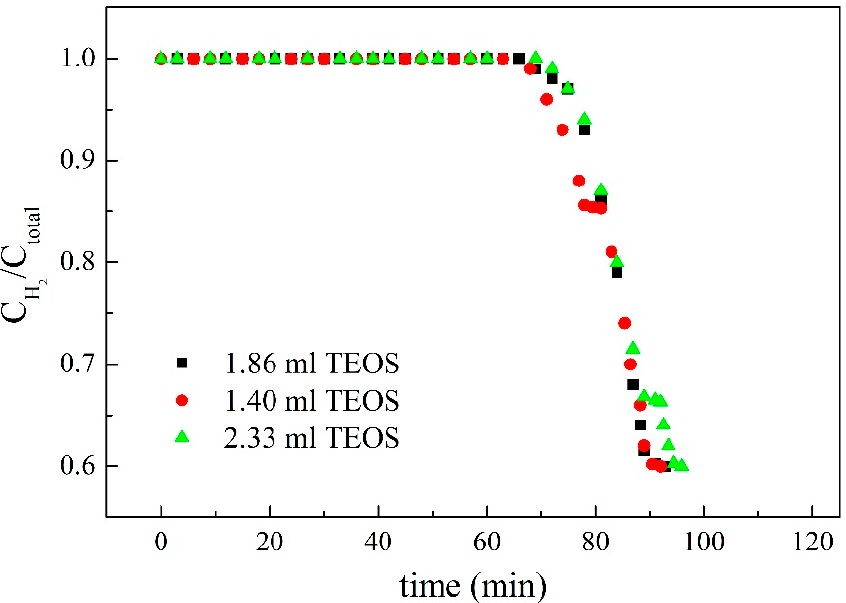
Figure 11. The effect of the addition of tetraethoxysilane (TEOS) on the ratio of hydrogen concentration to the total concentration of gas.